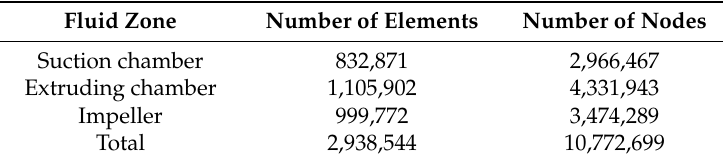
Table 2. Mesh information obtained in the current